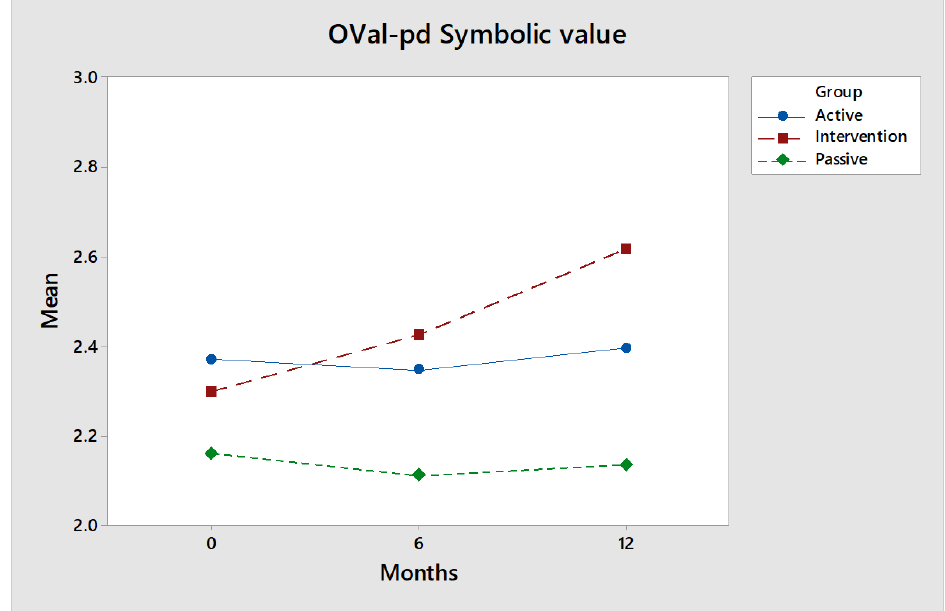
Figure 2. The Oval-pd symbolic value increases over time for the intervention group (red) while the values for the control groups (green and blue) are largely the same over time.